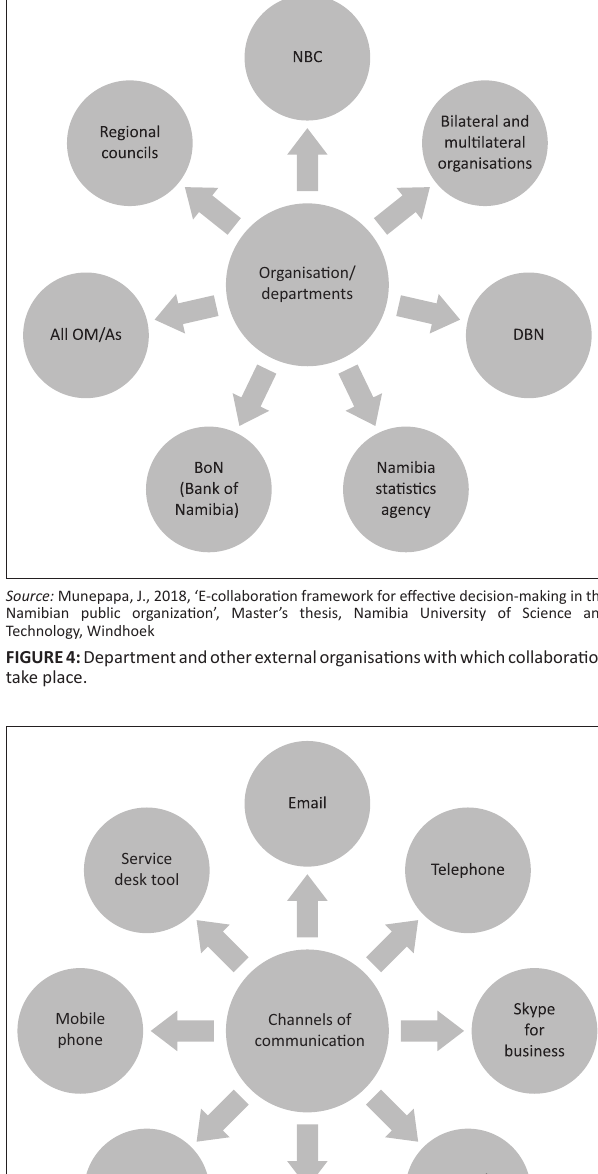
Channels of communica(cid:17)on